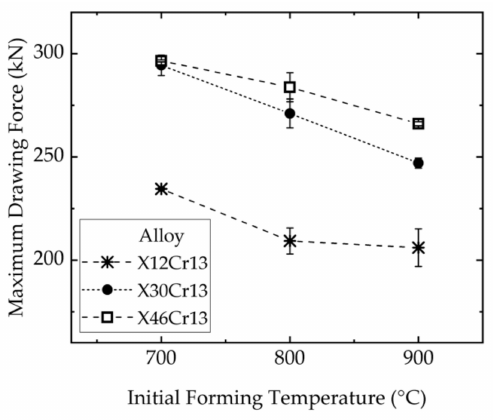
Figure 8. Maximum drawing force during forming of cups made of the alloy X12Cr13, X30Cr13, and X46Cr13 at initial forming temperatures of 700 ◦ C, 800 ◦ C and 900 ◦ C; blank diameter 170 mm; drawing depth 40 mm; drawing speed 20 mm / s; and an initial austenitization at 1050 ◦ C for 300 s.